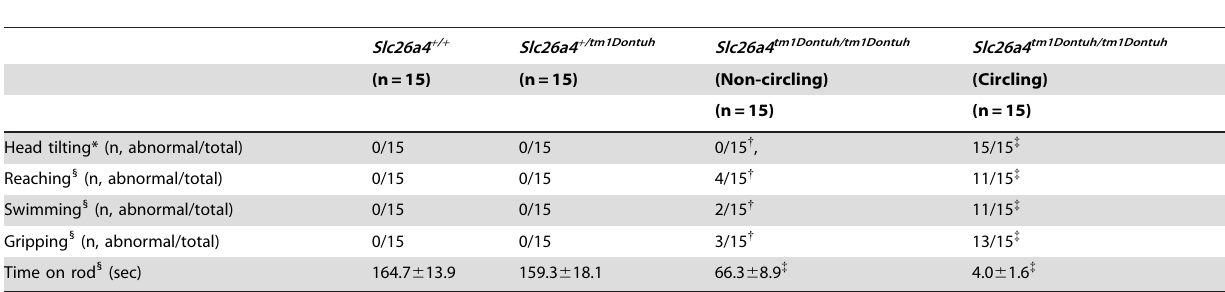
Table 1. Comparison of vestibular features according to the genotypes and the circling behavior.